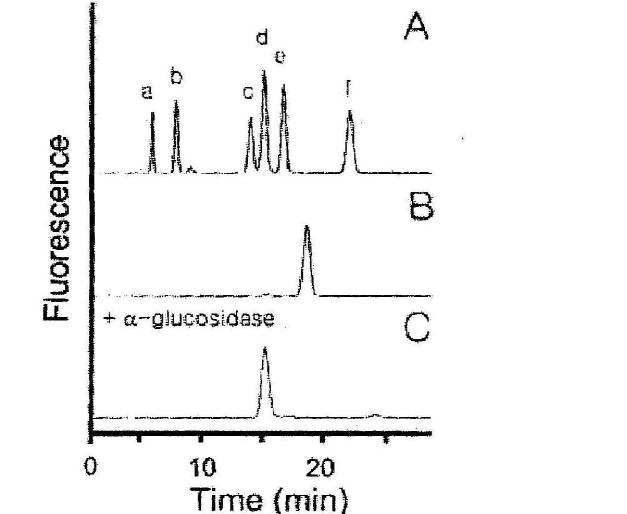
Figure 1. Identification of the glycosidic bond linkage in the biopterin-glucoside isolated from Synechococ cus sp. PCC 7942. (A) Standard pteridines: a, neop terin; b, cyanopterin; c, pterin; d, biopterin; e, 6- hydroxymethylpterin; f, dictyopterin. (B) the purified biopterin-glucoside. (C) the biopterin-glucoside diges ted by a-glucosidase. Pteridines were eluted isocrati cally with 10 ruM sodium phosphate, pH 6.0, at a flow rate of 1.2 ml min-l and detected with a fluorescence detector (350/450 nm).